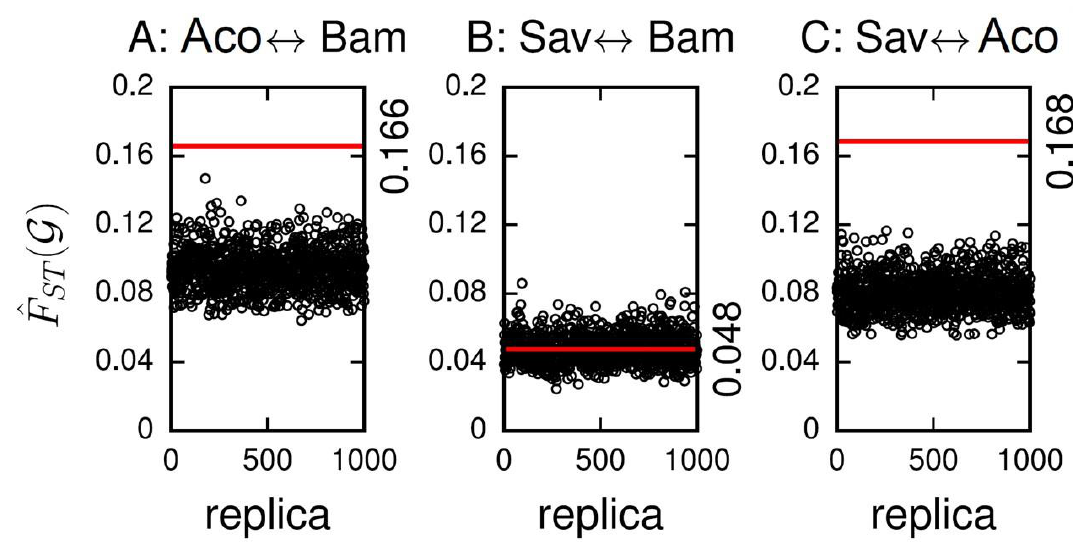
Figure 3. Bootstrap comparison of FST values for immune vs. non-immune genes. The FST value for the set of 231 immune genes (red line; value noted on the right side of each panel) compared with FST values from 1000 randomly selected equal sized sets of non-immune genes (black open circles).